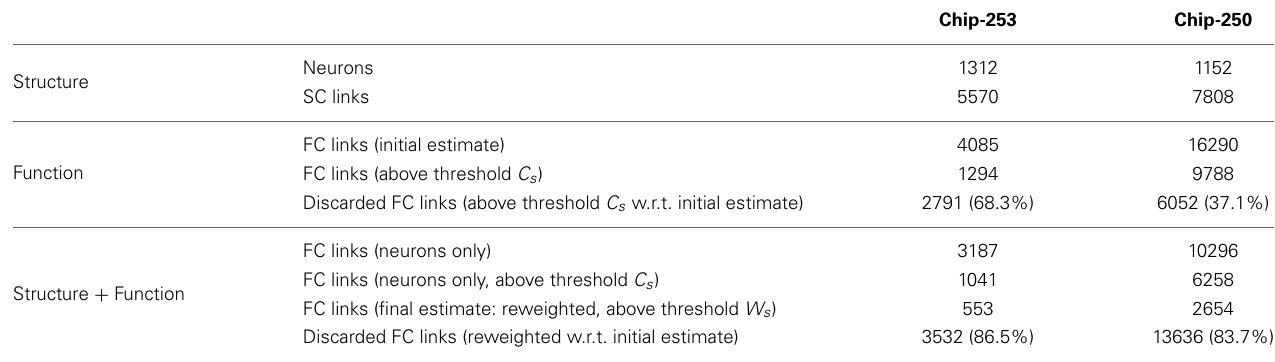
Table 2 | Quantitative structural/functional